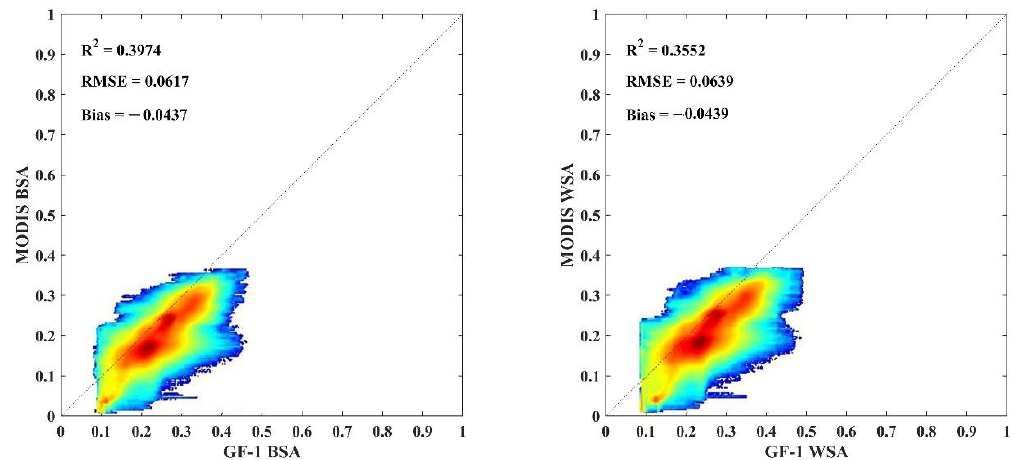
Figure 11. Scatter plot of GF-1 albedo and MODIS albedo in Sindh.